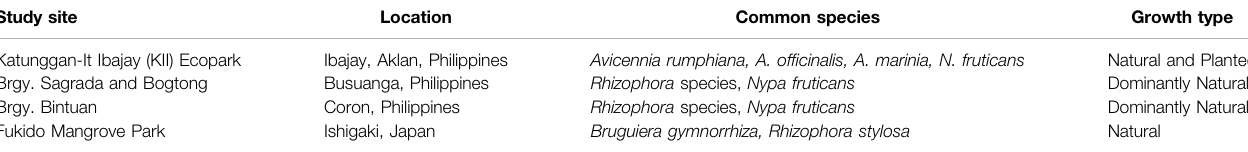
TABLE 1 | Common species and growth type of mangrove forests in the study sites.